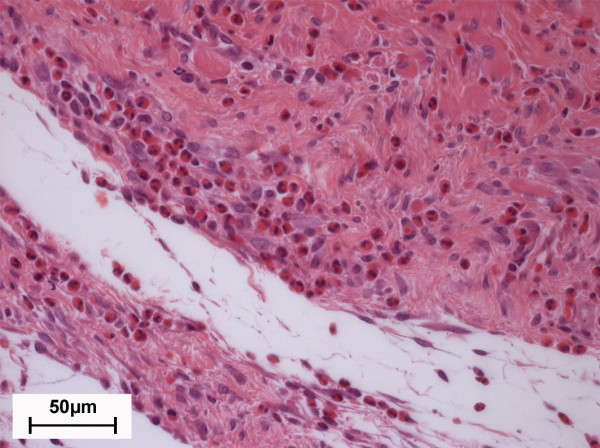
Image section of the periimplant fibrous tissue of an MgCa0.8 screw eight weeks postoperatively showing moderate infiltrations of heterophil granulocytes that are clearly observable due to their lobulated nucleus and red cytoplasmic granules (H. E., 400×).